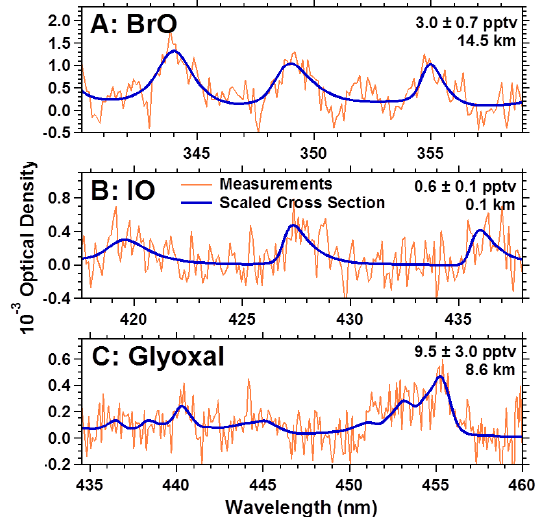
Figure 2. Spectral proof of the detection of BrO, IO and gly- oxal. Fitted cross sections are overlaid on measured signal includ- ing the noise level of the instrument. All spectra are recorded with EA0. Date, time, location, altitude and solar geometry are as fol- lows. BrO(RF12): 14 February 2012, 18:54UT, 101.2 ◦ W/8.7 ◦ N, 14.5km, 21.7 ◦ SZA; IO(RF17): 26 February 2012, 15:28UT, 91.7 ◦ W/5.9 ◦ N, 0.1km, 45.1 ◦ SZA; glyoxal (RF12): 14 February 2012, 19:01UT, 100.2 ◦ W/8.7 ◦ N, 8.6km, 21.8 ◦ SZA.